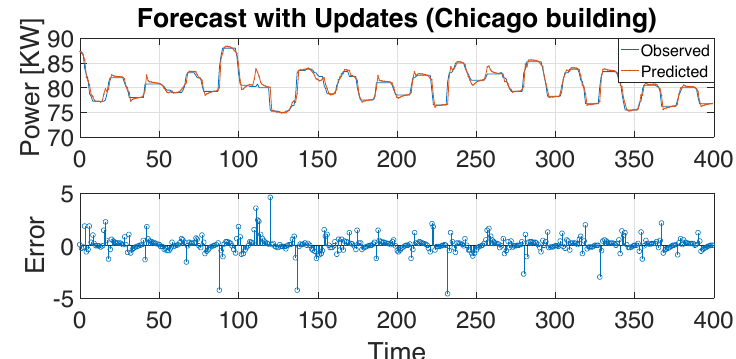
Figure 5. Building load forecasting with 50 unit recurrent neural network (RNN) LSTM: